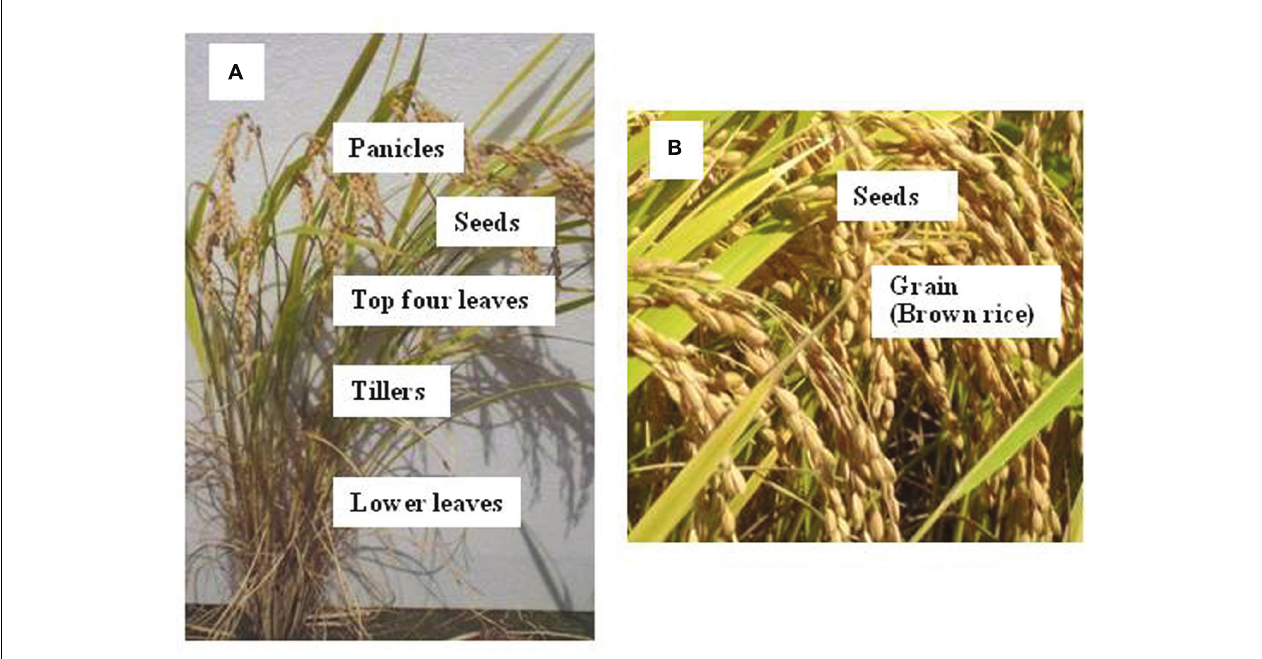
FIGURE 1 | Pictures showing a hill (A) and canopy (B) of Koshihikari, a high eating-quality rice, at their harvest (5,400 kg ha − 1 of brown rice) in the Fukushima district, Japan. Pictures taken on September 29, 2015.